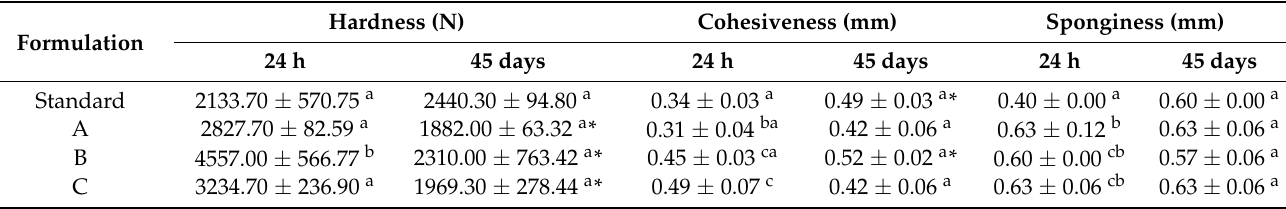
a,b,c : Different letters in same column denote statistically significant differences ( p ≤ 0.05, Tukey test). The values for each texture component in the different formulations were compared statistically taking the standard formulation as a reference. * Asterisk on same line denotes a significant difference after storage ( p ≤ 0.05, Tukey